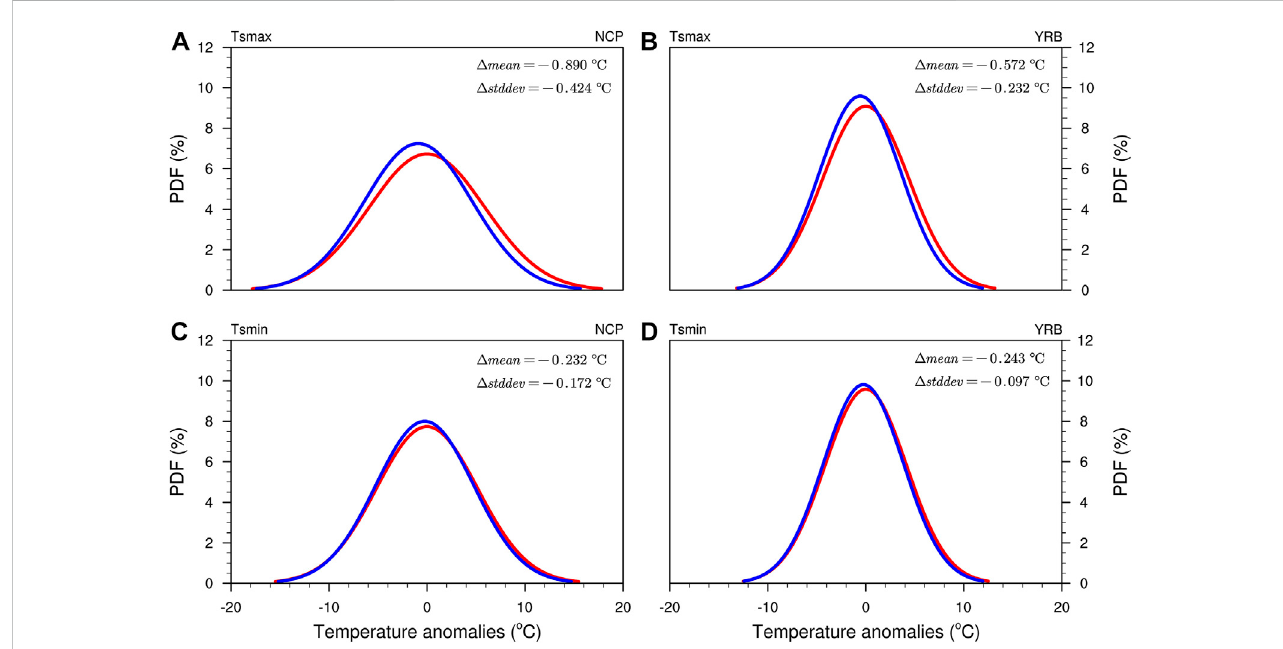
FIGURE 6 TheGaussian fi ttedprobabilitydensity function(PDF)oflandsurfacetemperatures forCTL(red)andIRR(blue)experiments: (A) Tsmax inNCP; (B) Tsmax in YRB; (C) Tsmin in NCP and (D) Tsmin in YRB. Note that the Δ mean and Δ stddev denote the irrigation-induced changes in the mean state and standard deviation of